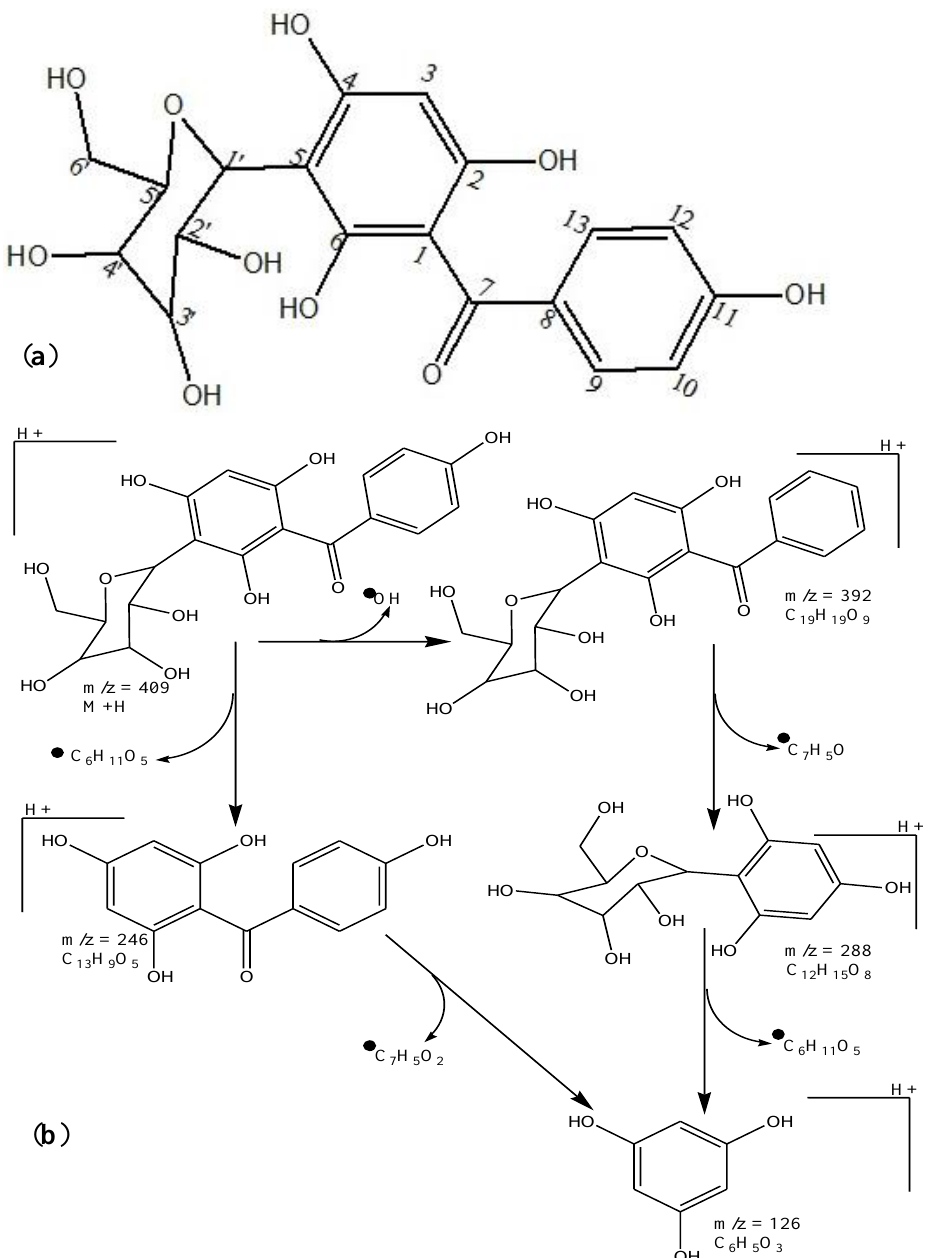
Figure 6. (a) Structural formula of “iriflophenone -3-C- β - D glucopyranoside” isolated from AqF of Figure 6. ( a ) Structural formula of “iriflophenone-3-C- β -D glucopyranoside” isolated from AqF of D. D. ramosa and (b) Proposed fragmentation scheme of iriflophenone-3-C- β -D glucopyranoside. Mo- ramosa and ( b ) Proposed fragmentation scheme of iriflophenone-3-C- β -D glucopyranoside. Molecular lecular ion is (M + H) 409 m/z . This scheme is based on fragments peaks observed for iriflophe- ion is (M + H) 409 m / z . This scheme is based on fragments peaks observed for iriflophenone-3-C- β -D none-3-C- β -D glucopyranoside during ESI-TOF/MS (positive ion mode). glucopyranoside during ESI-TOF/MS (positive ion